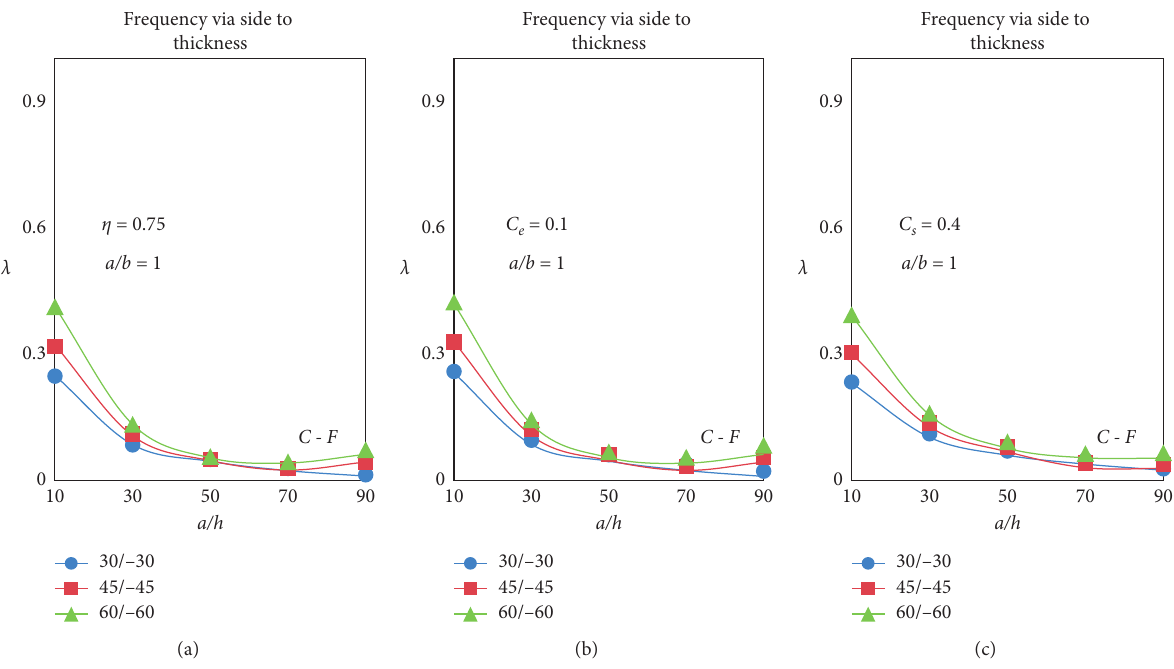
Figure 6: Influence of side-to-thickness ratio on frequency parameter value of 2-layered plates: EGE/EGE.